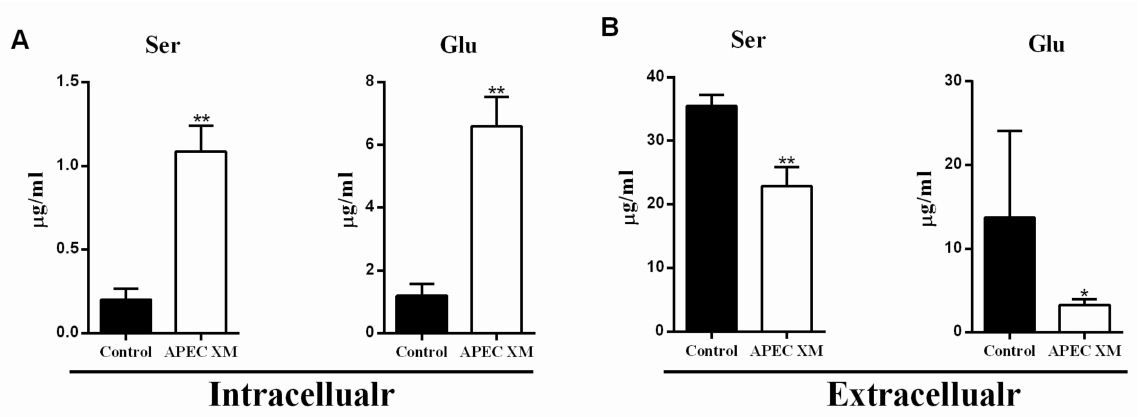
Figure 1. APEC XM infection promotes uptake of serine, and glutamate in bEnd.3 cells at 1 h. ( A ) The intracellular content of serine and glutamate; ( B ) The extracellular content of serine and glutamate. Data are from one experiment representative of three independent experiments, with six replicates per group. Data represent means ± SD. * p < 0.05, ** p <